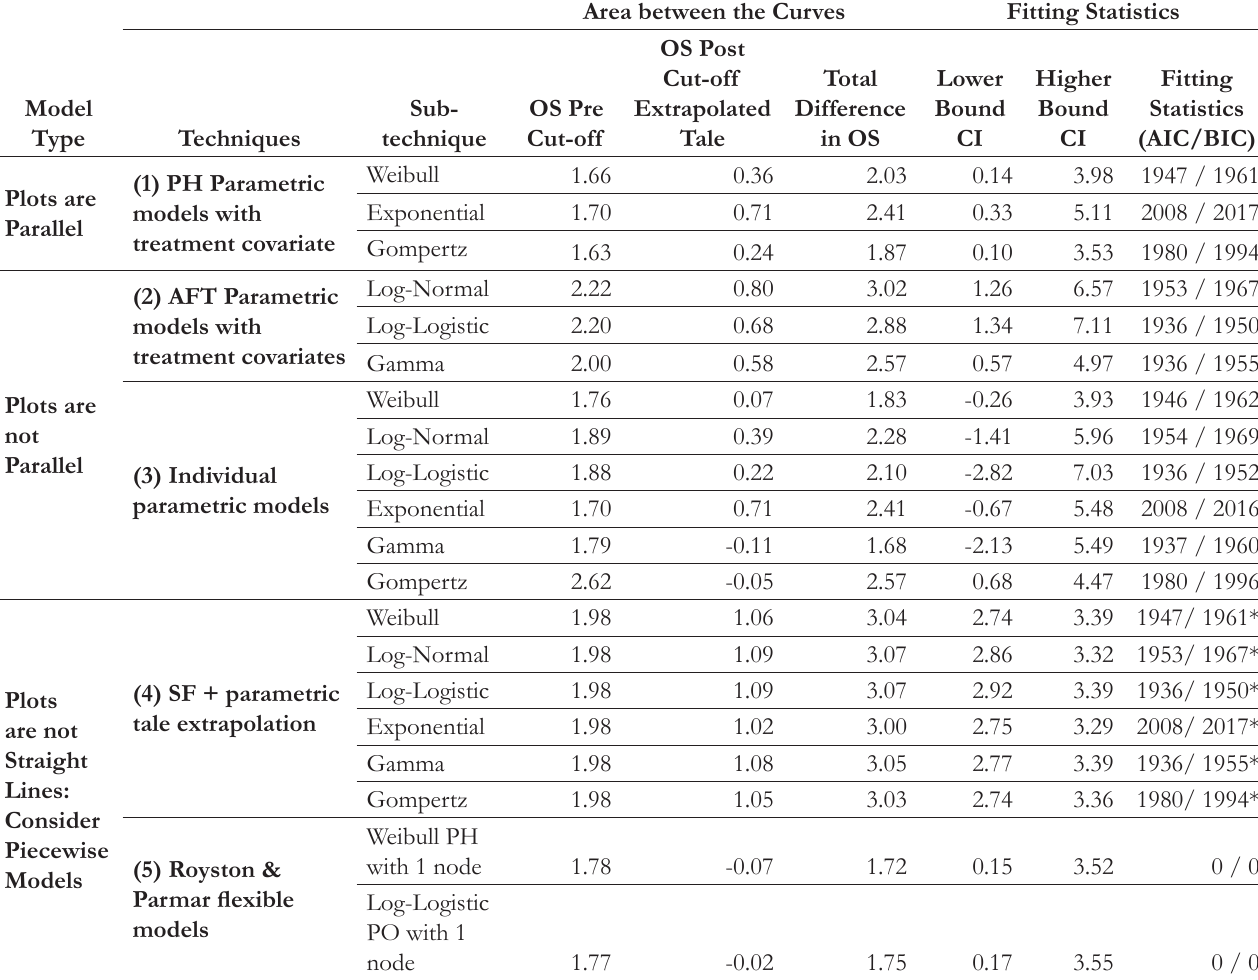
Table 1. Overall Survival Extrapolation Results